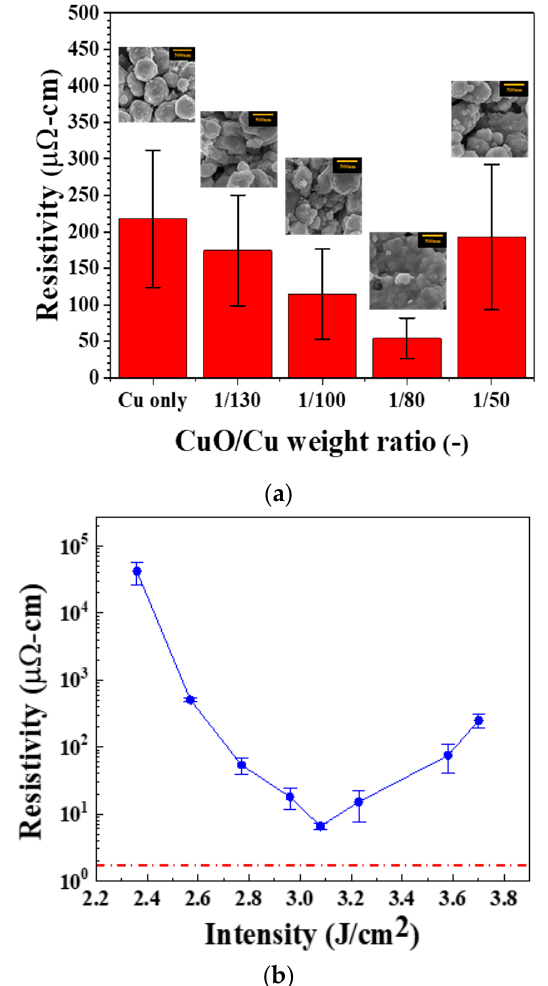
Figure 6. ( a ) Resistivity vs weight ratio of copper film, cupric oxide nanoparticles (CuONP) / CuNP. A single pulse with an energy density of 2.77 J / cm 2 is used. ( b ) Resistivity of CuONP / CuNP (1 / 80 weight ratio) film sintered by single pulse IPL at various energy